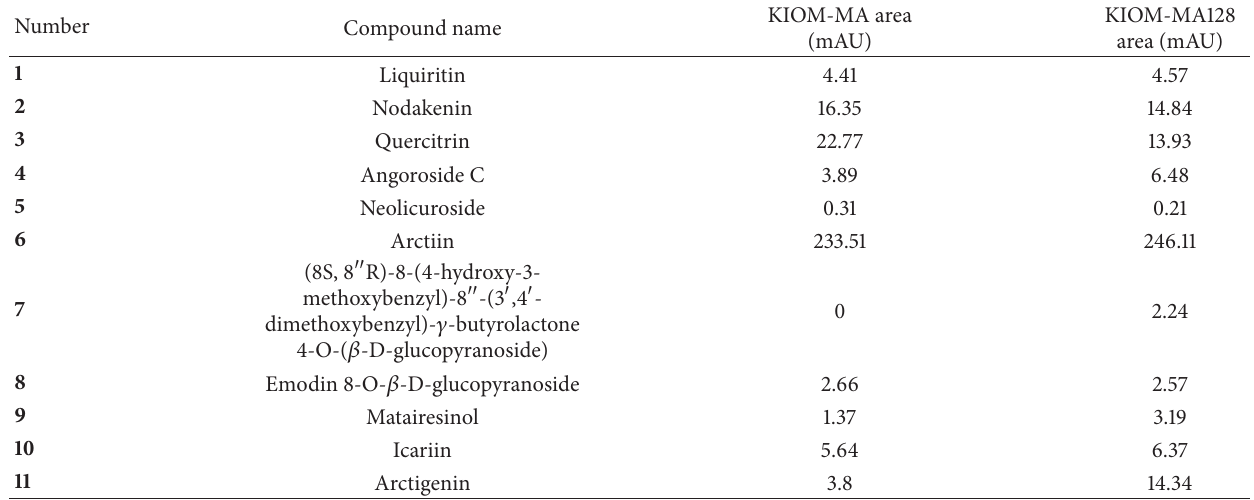
Table 1: List of the changed eleven markers and peak areas from